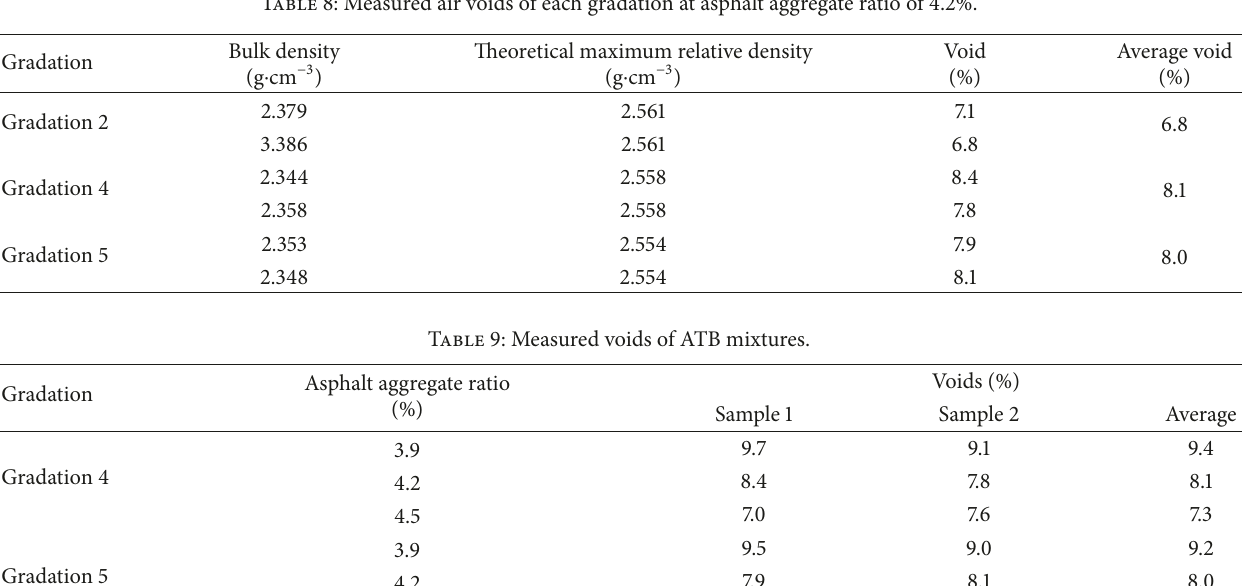
Table 8: Measured air voids of each gradation at asphalt aggregate ratio of 4.2%.